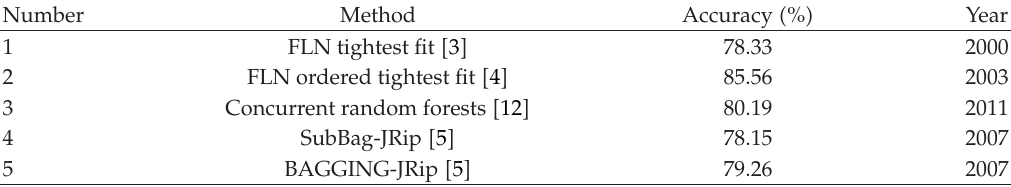
Table 1: Comparison of accuracy for “cylinder bands” data set in di ff erent data mining methods.